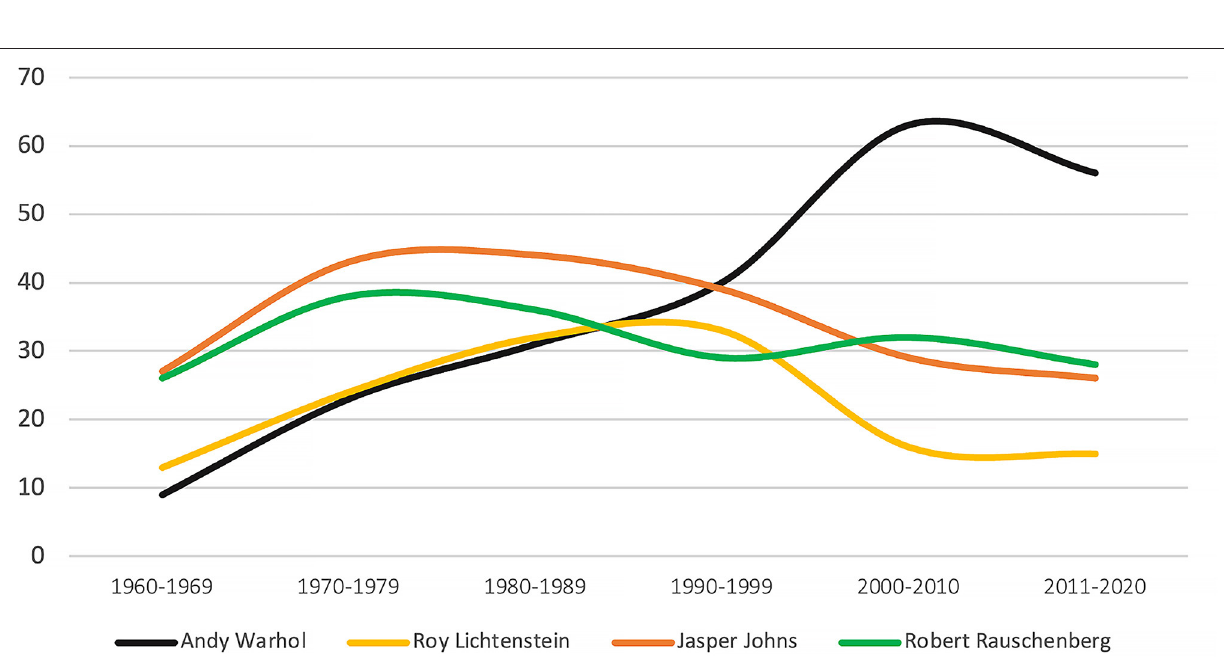
FIGURE 3 | Number of exhibitions (solo and group) at the Museum of Modern Art, New York (1960–2020). Source: Developed by the authors based on data from the Museum of Modern Art online